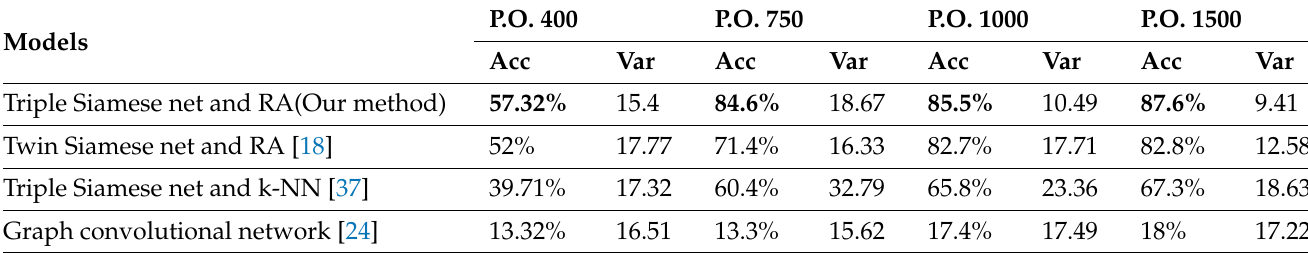
Table 2. Precision Comparison of our model with other models for different partial-observation sizes.